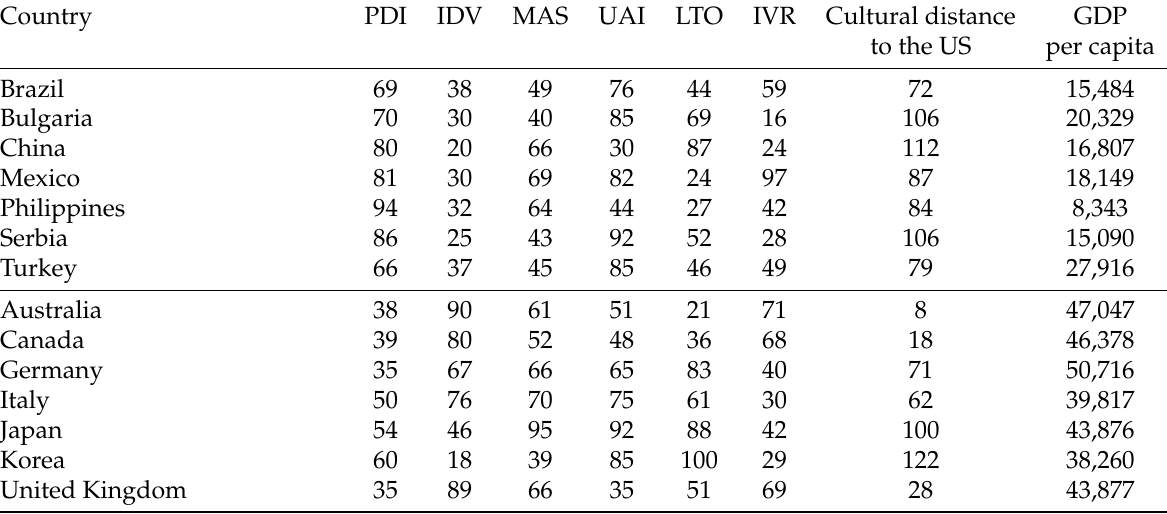
Table 1: Characteristics of the countries used as treatments.